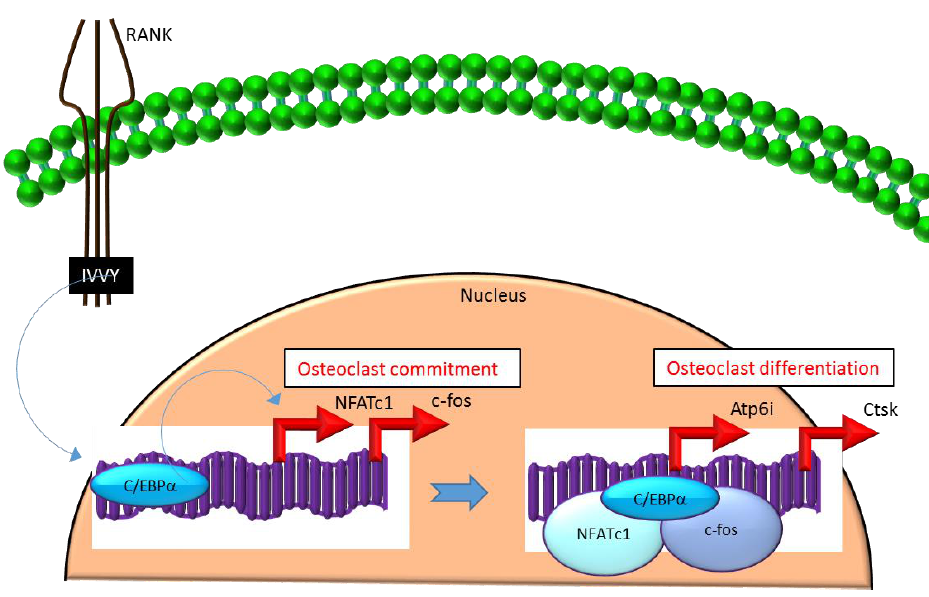
Figure 2. C/EBP  promotes lineage commitment, differentiation and function of osteoclasts. An increase in C/EBP  expression in HSCs is mediated through activation of IVVY motif of the cytoplasmic domain of RANK. C/EBP  can activate transcription of the master osteoclastogenic osteoclastogenic target genes and promote osteoclast di ff erentiation. Blue colored arrow-ended lines: stimulation / activation. Red colored pointed arrows: transcriptional Blue colored arrow-ended lines: stimulation/activation. Red colored pointed arrows: transcriptional activation .